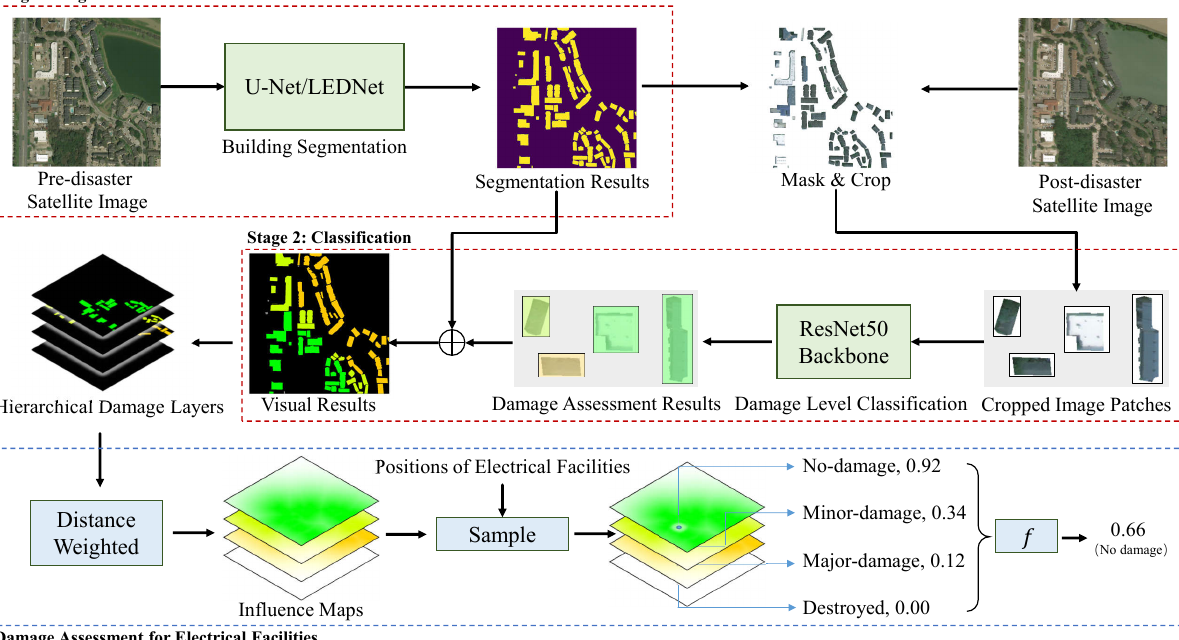
Figure 2. Pipeline of our